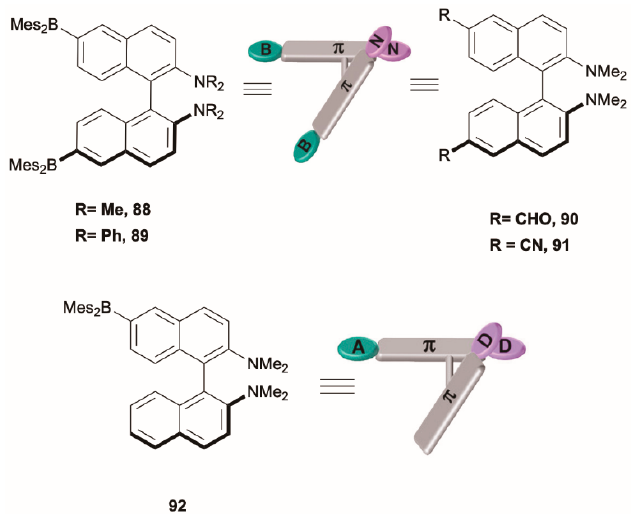
Figure 21. Schematic presentation and structure of o , o ′ -binaphthyls 88 – 92 consisting of two D– π –A subunits. Adapted with permission from [80].